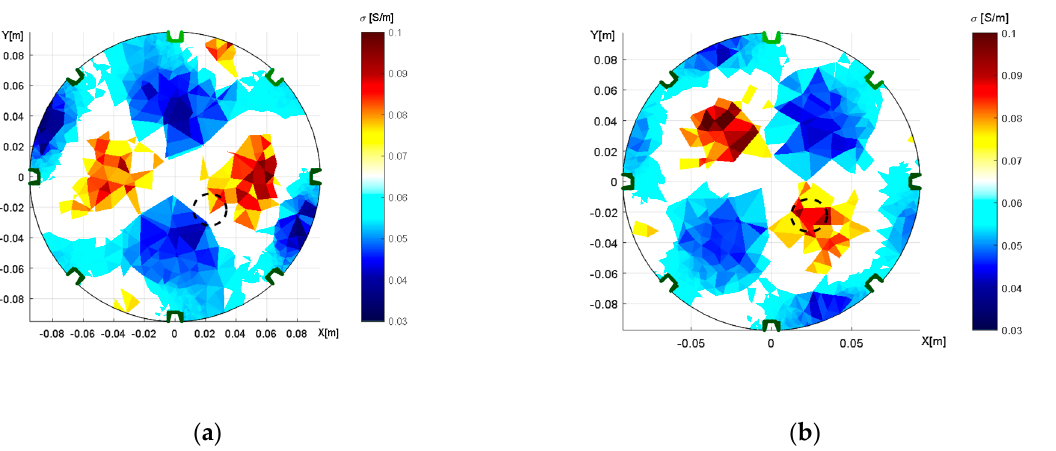
Figure 10. The distribution of conductivity in the water medium, obtained through opposite feeding and sensing; an aluminum object is inserted, and the tomograph’s axial dimensions correspond to X = 19.4 cm and Y = 18.6 cm. The images: ( a ) a wrongly selected circular shape; ( b ) the correct elliptic domain.